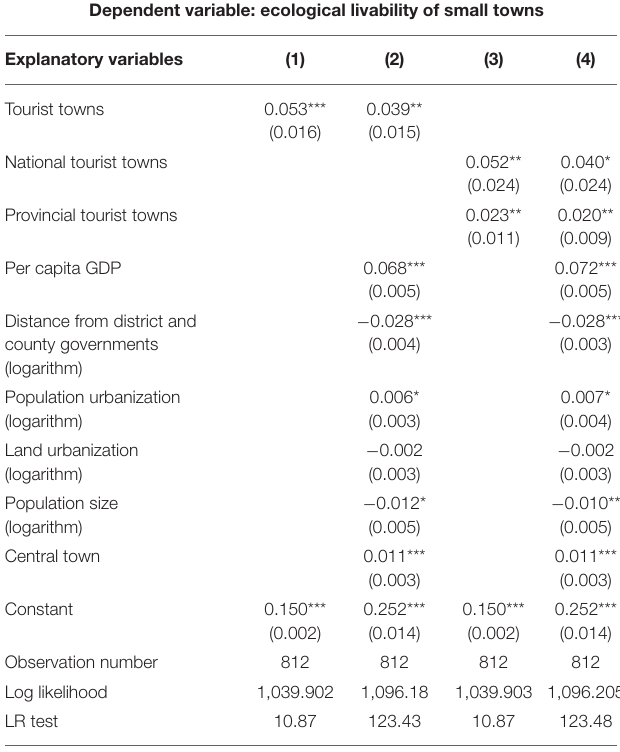
TABLE 4 | Results of benchmark and hierarchical